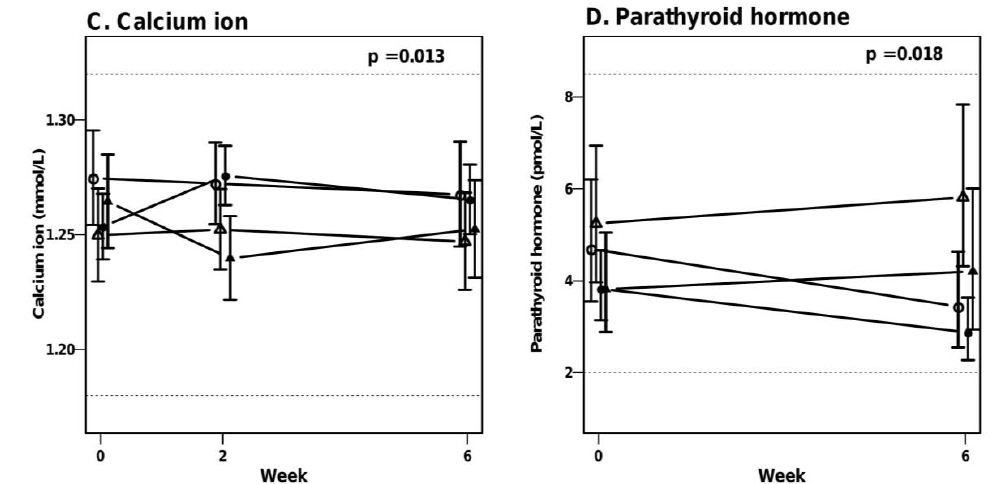
Figure 4. Vitamin D, calcium and parathyroid levels from week 0 to 6. “Week 6” also comprises rescue treated patients (week 3). A mixed model was used to test for parallel curves. Data are presented as medians with 95% CI. Dotted lines represent the reference range. ( A ). Changes in 25-hydroxyvitamin D 2 + D 3 (25-vitD) over time were significantly di ff erent in the four groups ( p < 0.0001) as expected. ( B ). Changes in active 1.25-dihydroxyvitamin D 3 (1.25-vitD) were also dependent on treatment ( p < 0.0001) with higher 1.25-vitD levels in the vitamin D treated groups. ( C ). Changes in calcium-ion levels over time were dependent on treatment ( p = 0.01), again with the highest levels in the vitamin D treated groups. However, all patient levels were within the reference range. ( D ). Changes in parathyroid hormone levels over time were dependent on treatment ( p = 0.018), though all patient levels were within the reference range. VitD, vitamin D; Ifx, Infliximab.